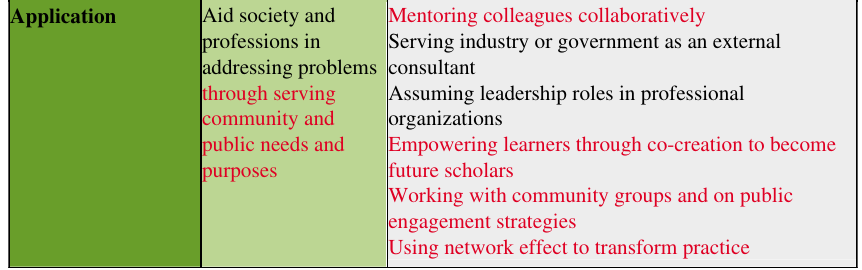
Figure 3. Application ‘type’ of Boyer’s Model of Scholarship